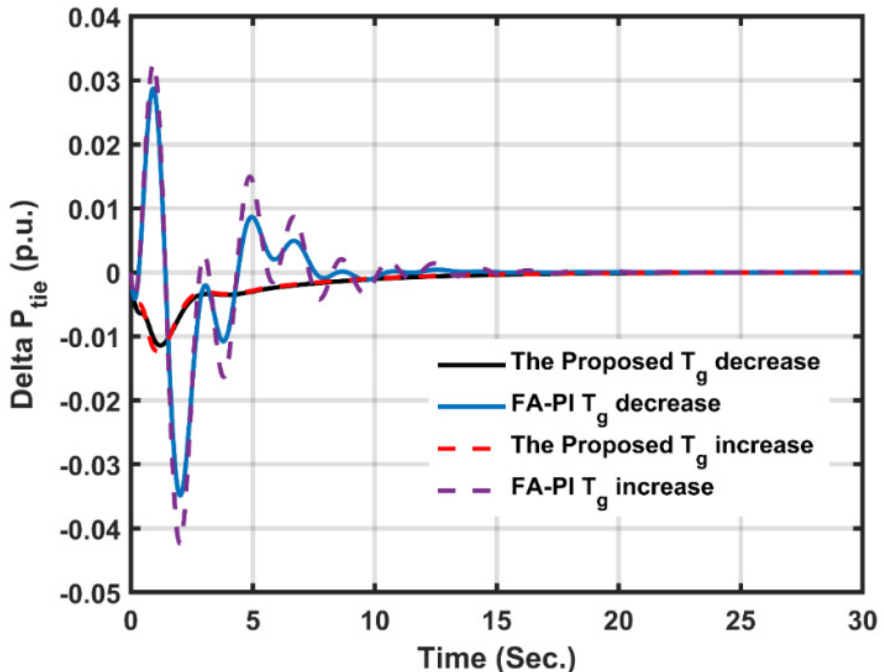
Figure 24. Tie line power deviation under T g changes.